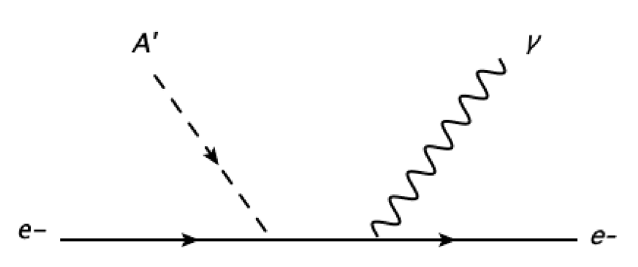
Figure 7 . Dark photon absorption process similar to Compton